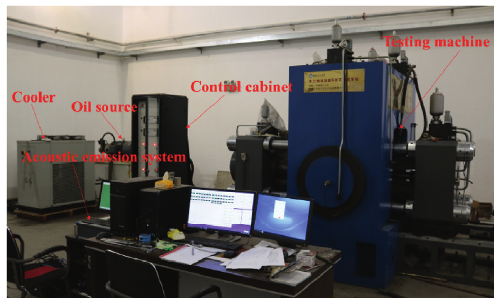
Figure 6: True triaxial disturbance unloading rock test